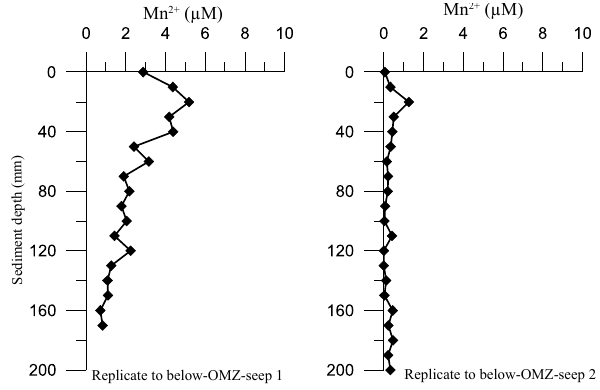
Fig. 4. Mn 2 + pore water concentrations measured on two push cores that were taken from similar positions (“replicate”) to below- OMZ-seep 1 (adjacent to gas orifice) and below-OMZ 2-seep (within the small clam